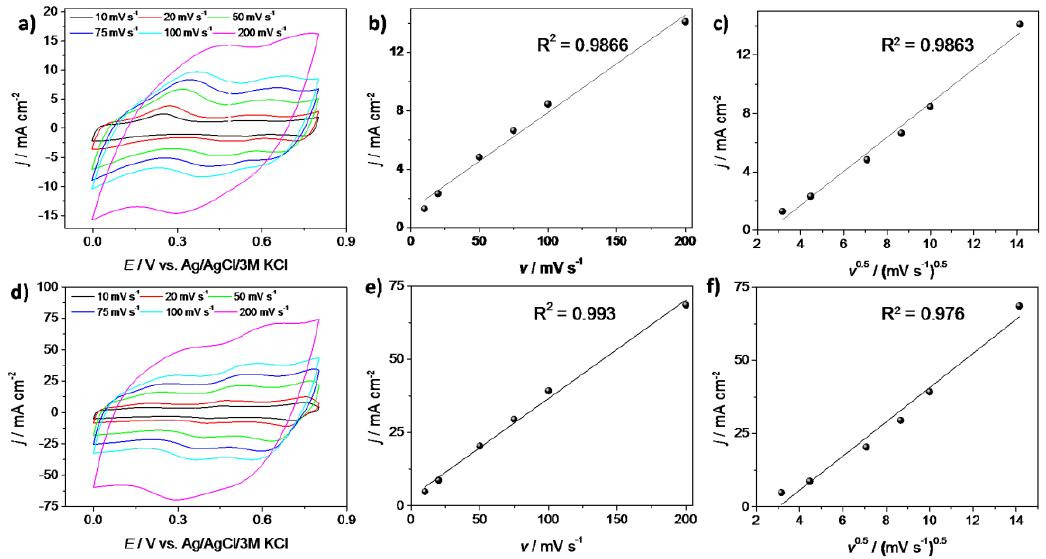
Figure 5. Cyclic voltammetry (CV) curves of ( a ) FTO/PANI/Cl and ( d ) FTO/PANI/WO 3 electrodes in 1 M H 2 SO 4 at different scan rates; ( b , e ) plots of j = f (v) and ( c , f ) j = f (v 1/2 ) at E = 0.6 V for FTO/PANI/Cl and FTO/PANI/WO 3 , respectively.